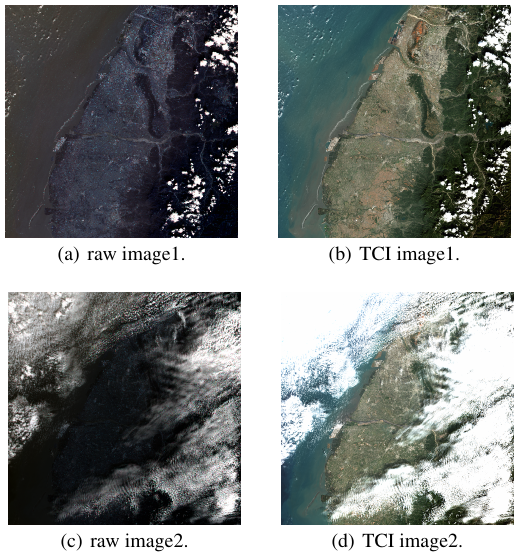
Figure 5. TCI image